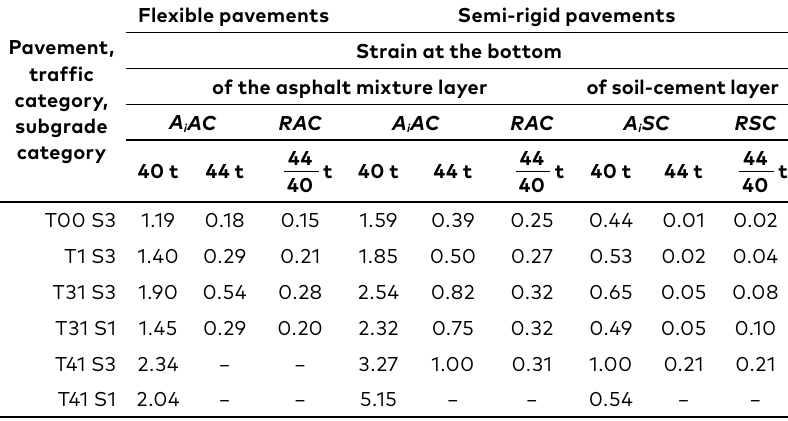
Table 5. Aggressiveness coefficients ratio between